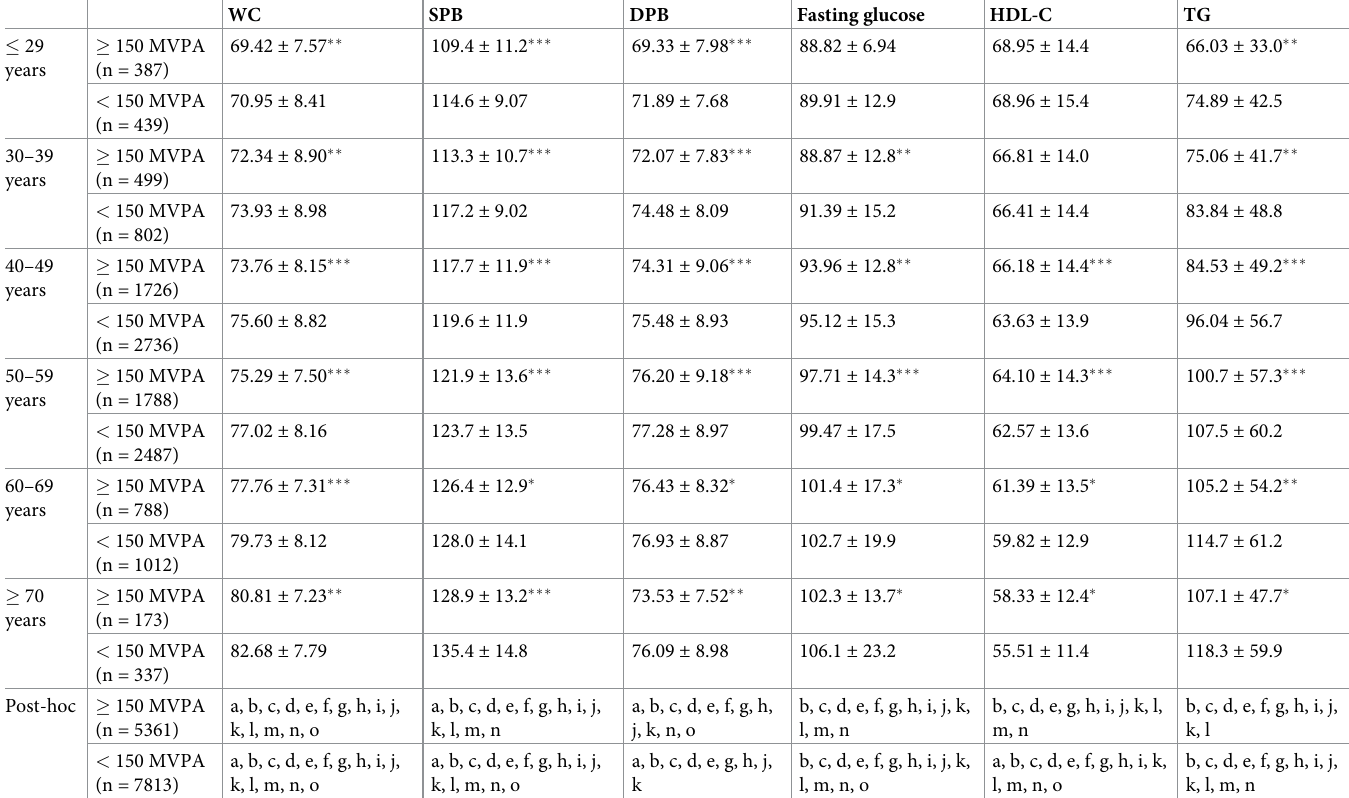
Table 3. Metabolic syndrome risk factors according to ages